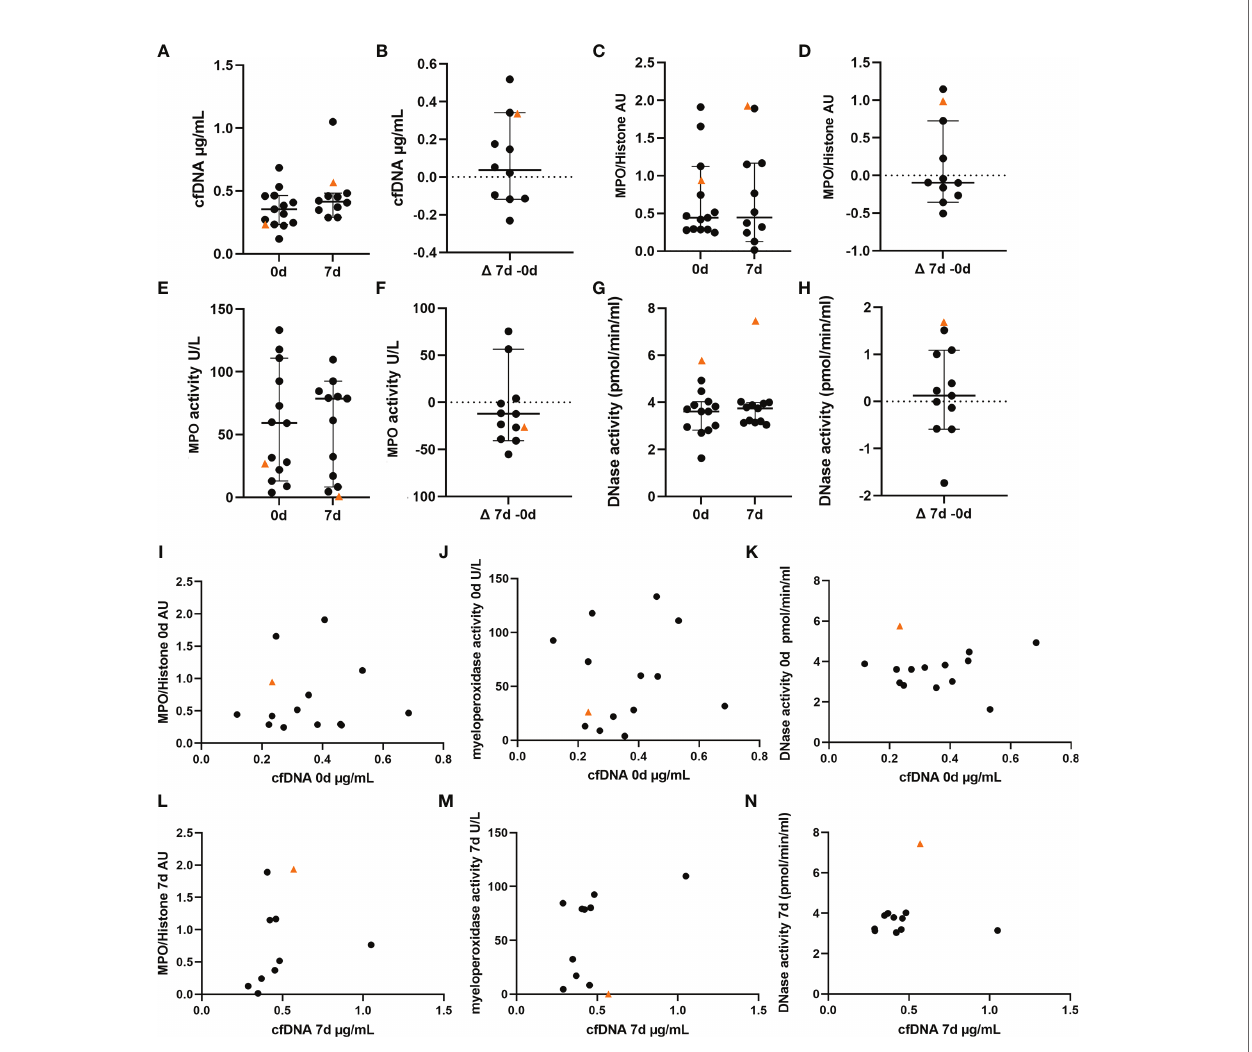
FIGURE 4 | NET markers in blood of VITT and control patients show highest DNase activity in VITT-patient. A-K NET marker analysis in blood of VITT-patient (orange triangle) and control patients (black dots) were measured in blood at onset (n = 13) and 7d post thrombectomy (n = 11) (A, C, E, G) . The delta of both measurements was calculated (B, D, F, H) . (A, B) Determination of cell-free DNA (cfDNA), (C, D) Determination of myeloperoxidase (MPO)-histone complexes, (E, F) Determination of MPO activity, (G, H) , Determination of endogenous DNase activity (regulator of NETs). All data are presented as scatter dot plot, black lines depict the median and whiskers depict 95% con fi dence intervals of control values in (A – H) . (I – N) Values of cfDNA in comparison with respective NET markers at onset at 7d of disease were plotted in separate